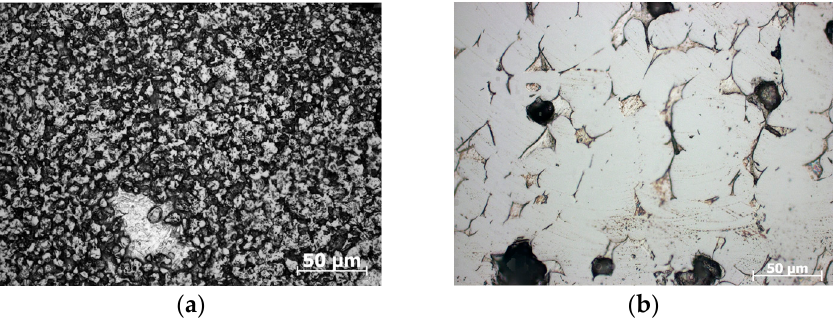
Figure 6. Microstructure of TiC-50% Ti synthesized powder: ( a ) before sintering at 1350 °C and ( b ) after sintering at 1350 °C.